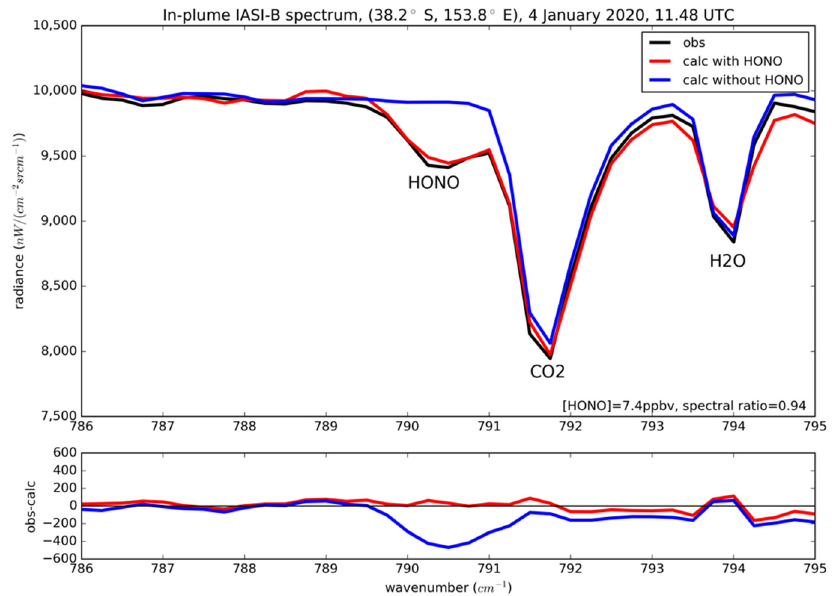
Figure 1. Example of a spectrum measured within an Australian fire plume detected on 4 January 2020 at 11.48 UTC by IASI-B. The observed spectrum (black) is compared to the direct radiative transfer calculation with (red) and without (blue) HONO included. The difference between the observed and the calculated spectra is displayed in the lower panel. The HONO contribution to the spectrum is visible between 790 and 791 cm − 1 . H 2 O and CO 2 main absorptions in the window are indicated in the figure .